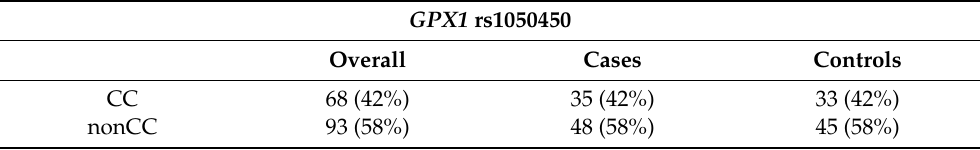
Table A3. Numbers of CRC cases and healthy controls depending on GPX1 gene polymorphism only.